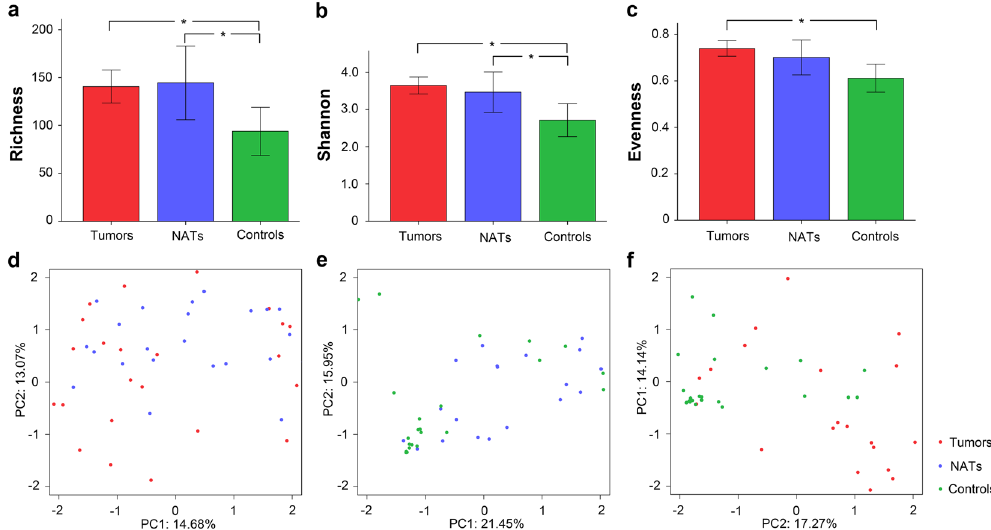
Figure 3. Comparative analyses of bacterial communities from the three groups of tissue samples from the larynx. The Richness ( a ), Shannon ( b ), and Evenness ( c ) of the samples from the tumor tissues, the normal tissues adjacent to the tumor sites (NATs) and control tissues are compared. The values present the means ± SEMs, * indicates p < 0.05. The tumor tissues and the NATs were collected from laryngeal carcinoma patients, and the control tissues were collected from control subjects. ( d ) A PCA based on weighted UniFrac distances was performed to analyze the community membership metrics of tumor tissues and NATs. ( e ) The bacterial community membership of NATs and control tissue samples was analyzed by PCA. ( f ) The bacterial community membership of the tumor tissues and the control tissue samples was analyzed by PCA. For the laryngeal carcinoma group, the communities from the tumor tissues appear in red, whereas communities from the NATs appear in blue. The communities from the control subjects appear in green. The statistical significance ( p value) was analyzed using the R package CrossMatch based on the UniFrac sample distance.